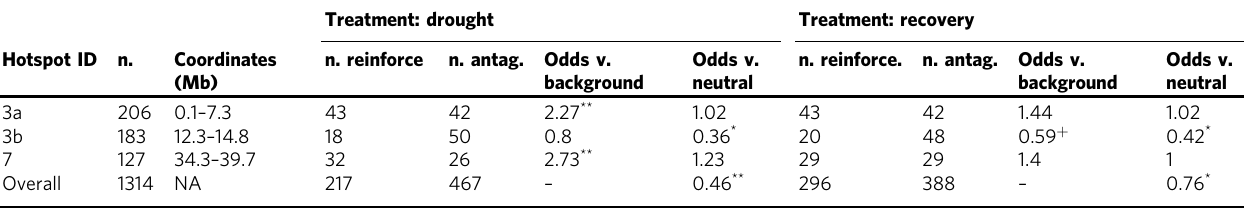
Table 3 Summary of direction of effects for genes with both cis- and trans-eQTL Treatment: drought Hotspot ID